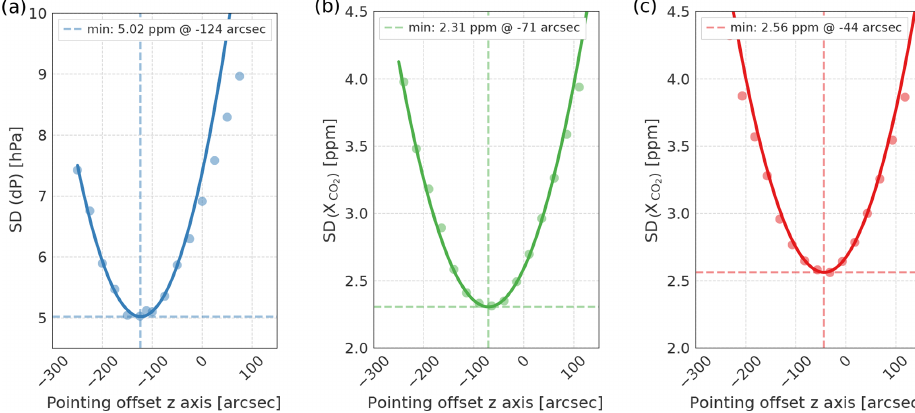
Figure 5. Standard deviation of d P ABP (a) and X CO rations for the Death Valley National Park.